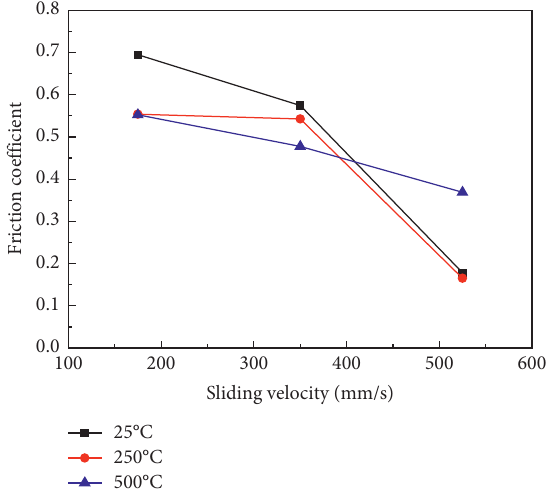
Figure 4: Effect of temperature on the friction coefficients of two different friction pairs at a sliding speed 525mm/s.